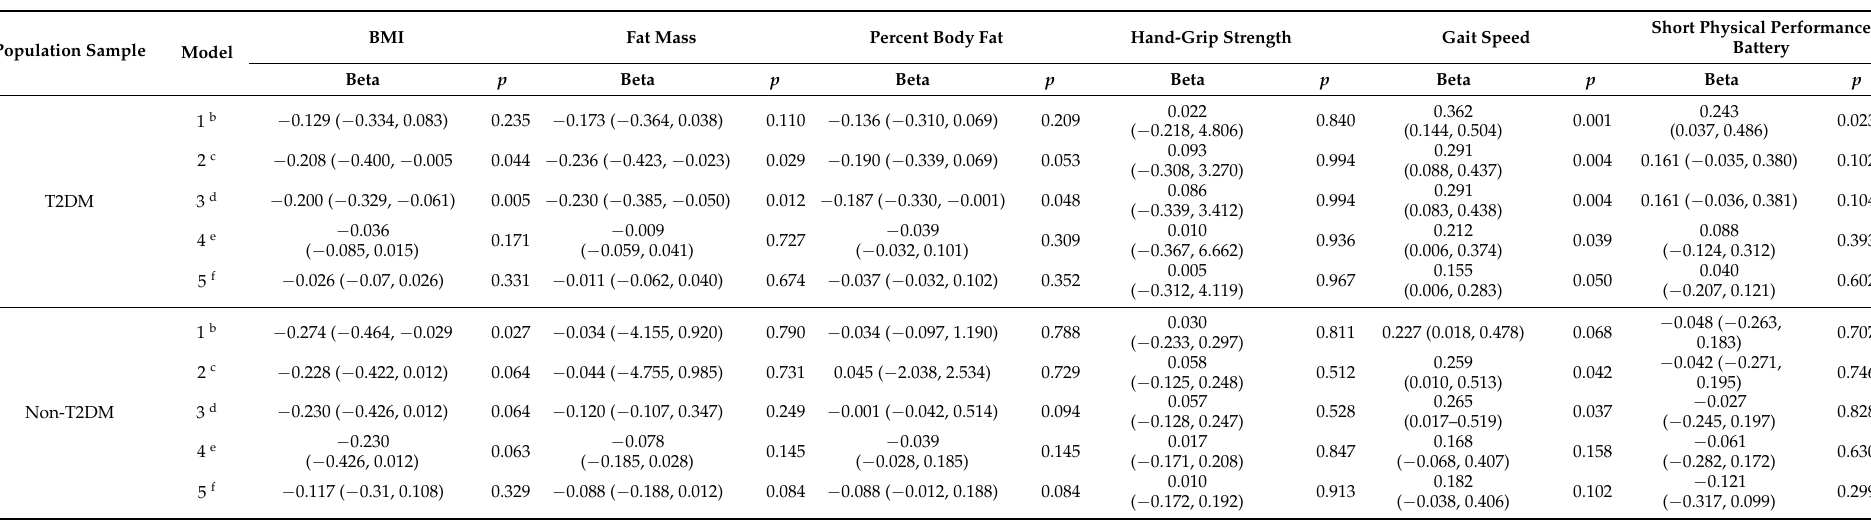
Table 2. Univariable and multivariable linear regression coefficients (and 95% CI) expressing independent associations between adherence to a Mediterranean diet and BMI, measures of adiposity, hand-grip strength, and physical performance by population sample. (standardised beta-coefficient (Beta)) a . Population